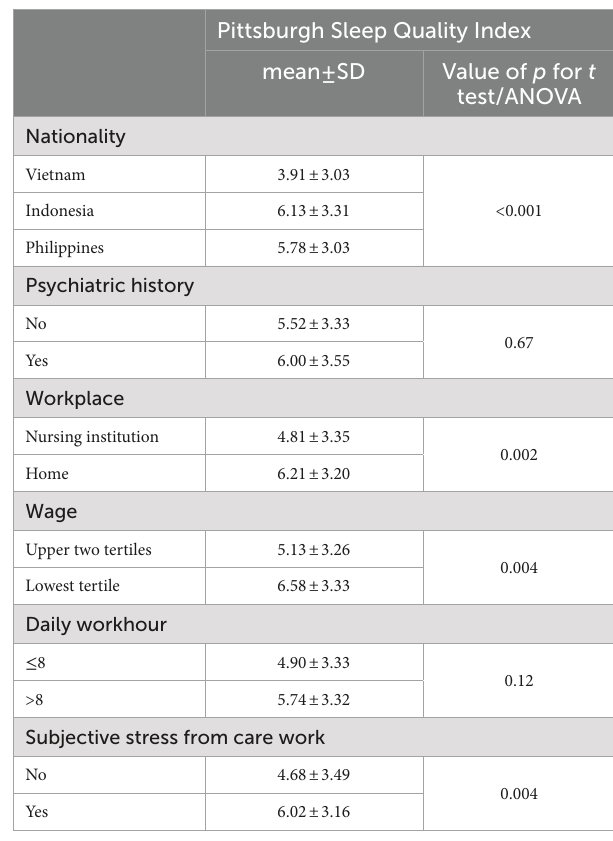
TABLE 3 Univariate analyses for factors associated with Pittsburgh Sleep Quality